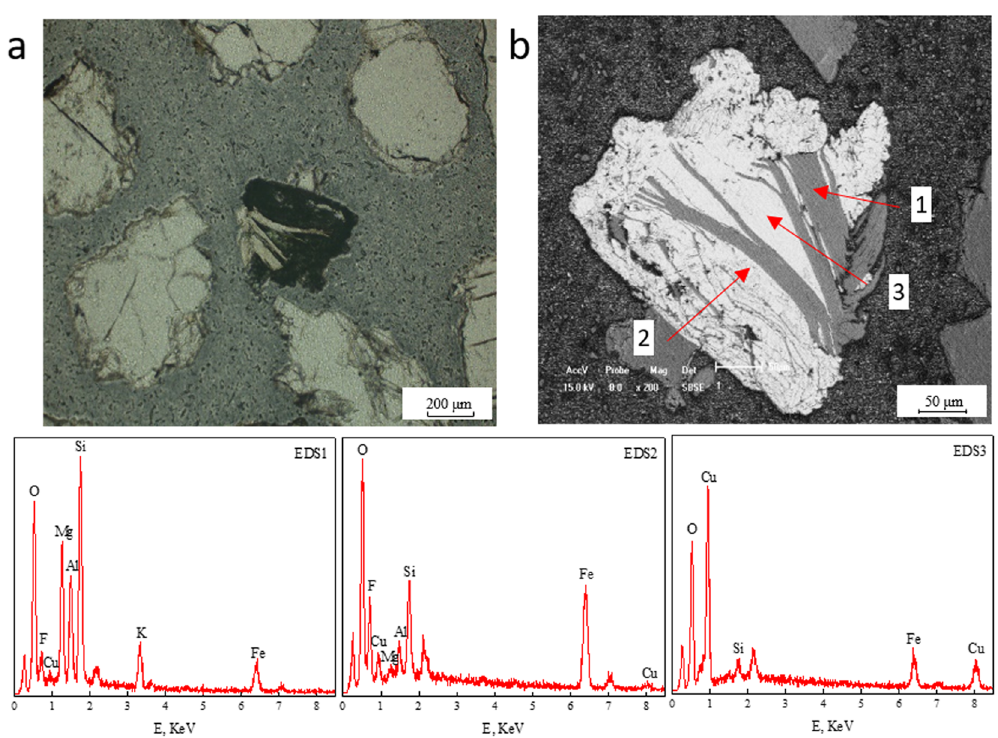
Figure 3. Planar polarizing microscopy and SEM-EDS diagrams of copper-bearing biotite altering into copper- bearing chlorite and copper-bearing limonite. ( a ) Planar polarizing microscopy. ( b ) SEM; EDS1, EDS2, EDS3. The spectra correspond to points 1, 2, 3 in SEM